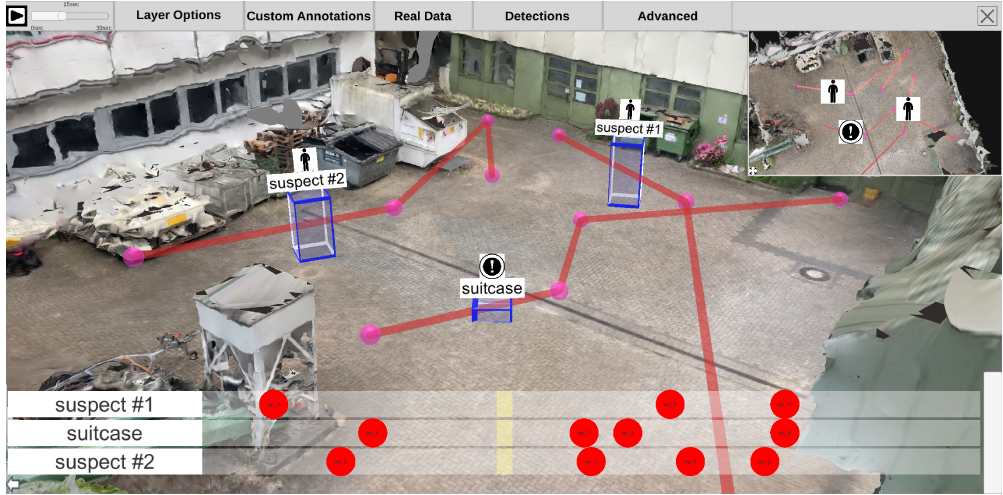
Figure 24. To animate annotations, waypoints can be set and arranged on a timeline that temporarily replaces the bottom panel. Waypoints determine the location of an annotation at a particular